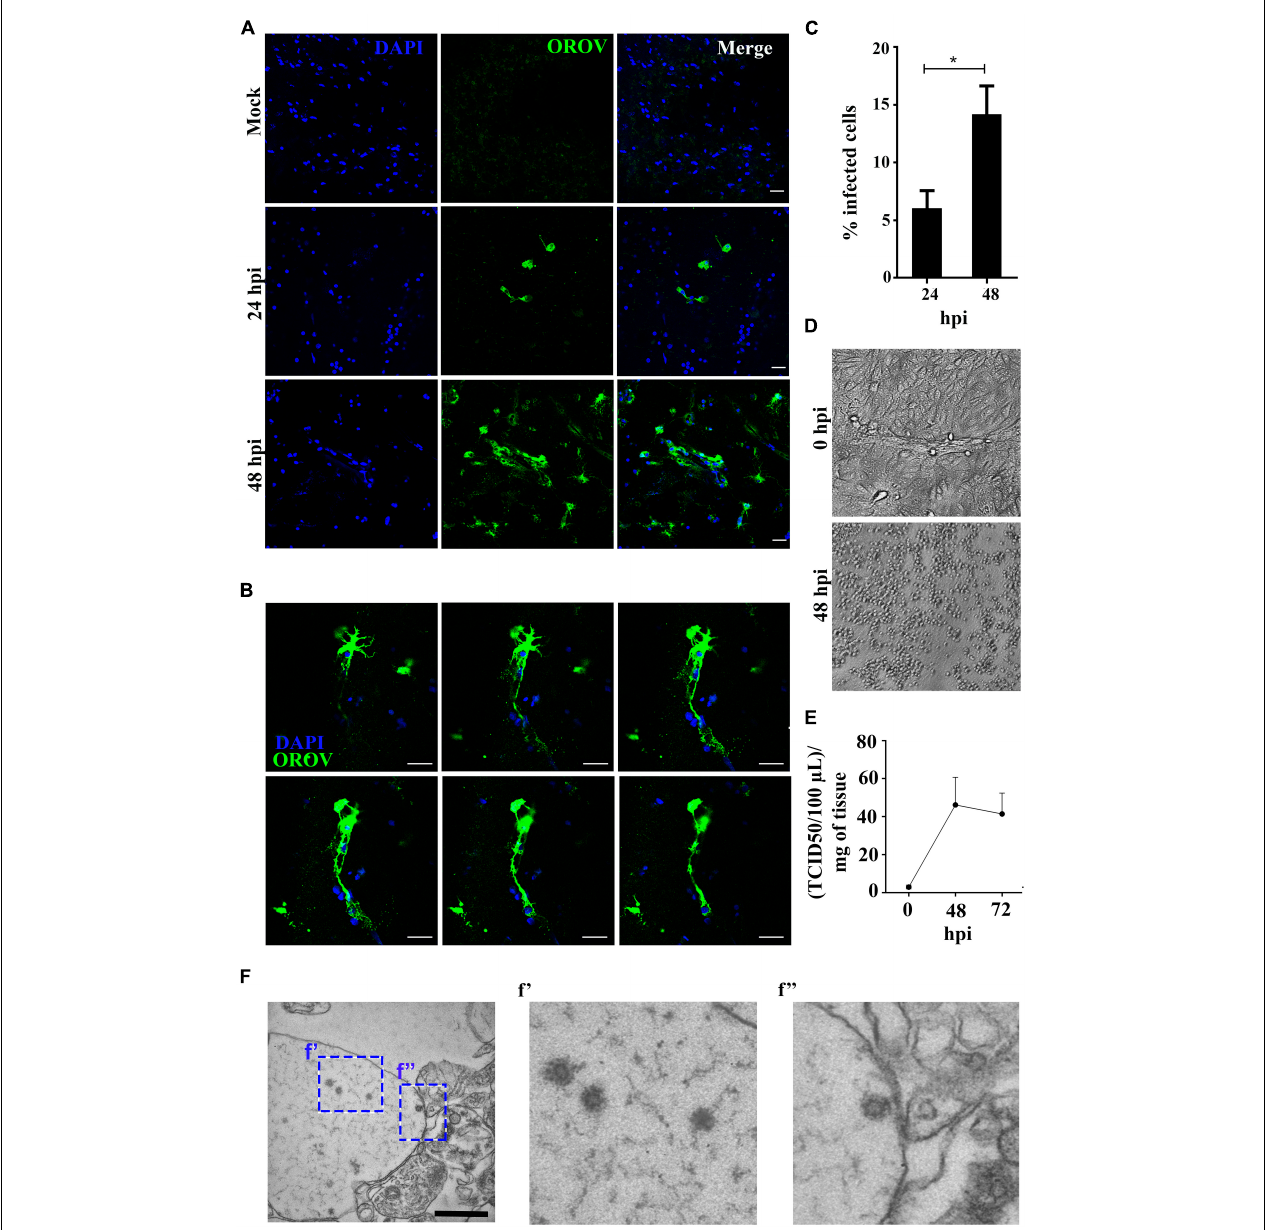
FIGURE 1 | Human neural cells in adult human brain slices are susceptible to ex vivo infection by Oropouche virus (OROV). (A) Representative confocal images of uninfected control (mock) and OROV-infected slices at 24 and 48 hours post infection (hpi). Tissue sections were stained for OROV (green) and nuclei (DAPI, blue) (Scale bar = 20 µ m). (B) Representative sequential Z-stack images from a cell infected by OROV in a human brain slice. Tissue was labeled for nuclei (DAPI, blue) and OROV antigen (green) (Z-Stacks = 0.5 µ m) (C) . Quantification of OROV positive cells at 24- and 48 hpi ( n = 4–9 donors). (D) Representative cytopathic effect observed in Vero cells inoculated with the 0- or 48 hpi supernatant (10 3 dilution) from the one brain slice culture. (E) Virus titers in the supernatant from brain slice infected by OROV ( n = 2 donors). (F) Representative transmission electron microscopy images of a human brain slice 48 hpi. Structures with typical virus particle morphology were observed ( f’ and f” , highlighted by the dashed square) (Scale bar = 1 µ m). Results are show as the mean ± SD. (* P < 0.05; Student t